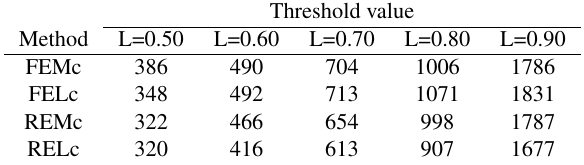
Table 9. Block design for DAP-TC (threshold is block).